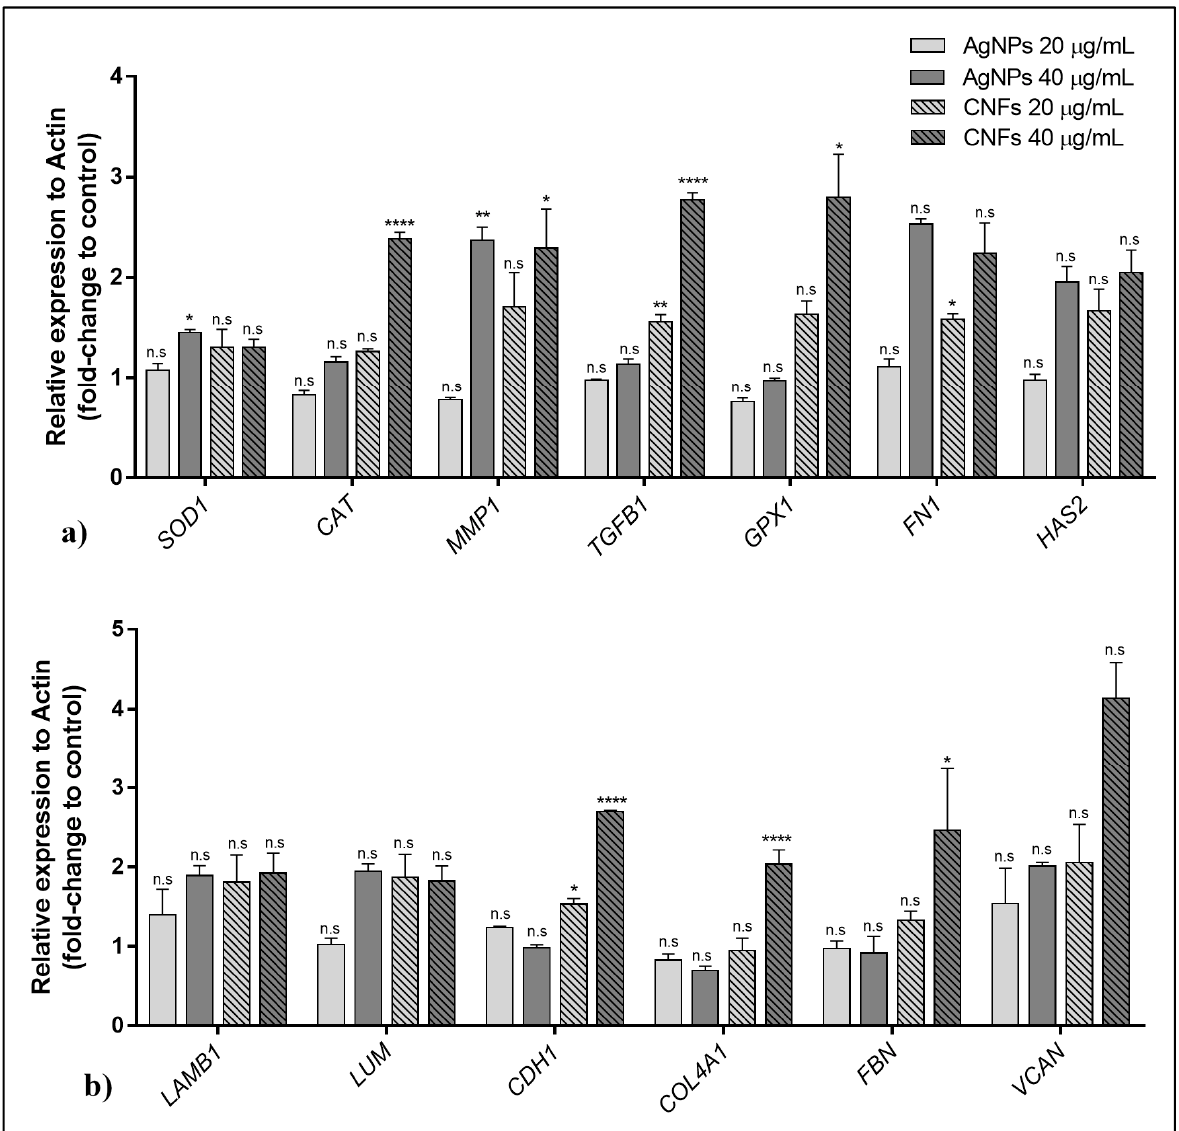
Figure 8. Effect of AgNPs and CNFs on the expression of thirteen genes: ( a ) SOD1, CAT, MMP1, TGFB1, GPX1, FN1, and HAS2 and ( b ) LAMB1, LUM, CDH1, COL4A1, FBN, and VCAN at two non-cytotoxic concentrations (20 and 40 µg/mL) in human keratinocyte (HaCaT) cells after 24 h. Data are shown as mean ± standard deviation from three replicates. The results are given as fold-change of control and relative expression to ACTB. * p < 0.05; ** p < 0.01; **** p < 0.0001; n.s: not significant).